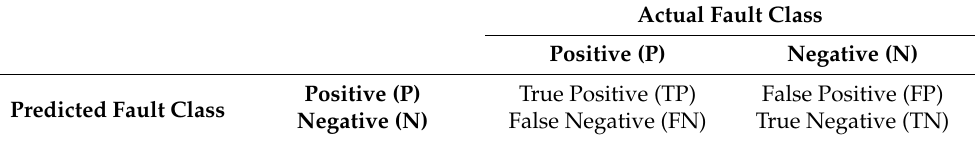
Table 3. The confusion matrix of a